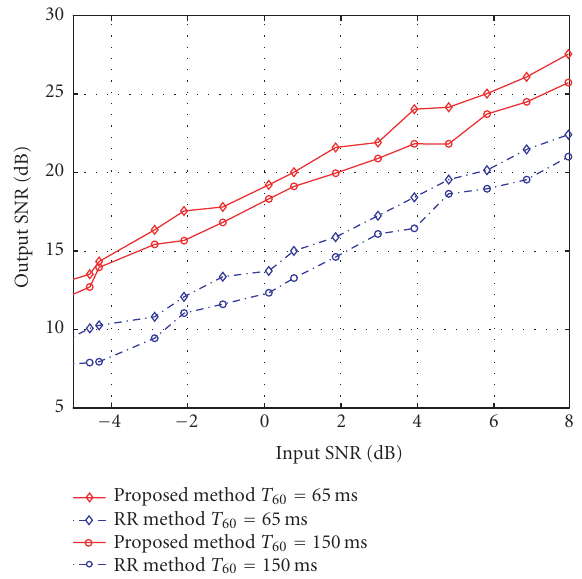
Figure 4: Comparison of the mean output SNR between RR-GSC and MF-GSC versus di ff erent input SNRs and di ff erent reverbera- tion